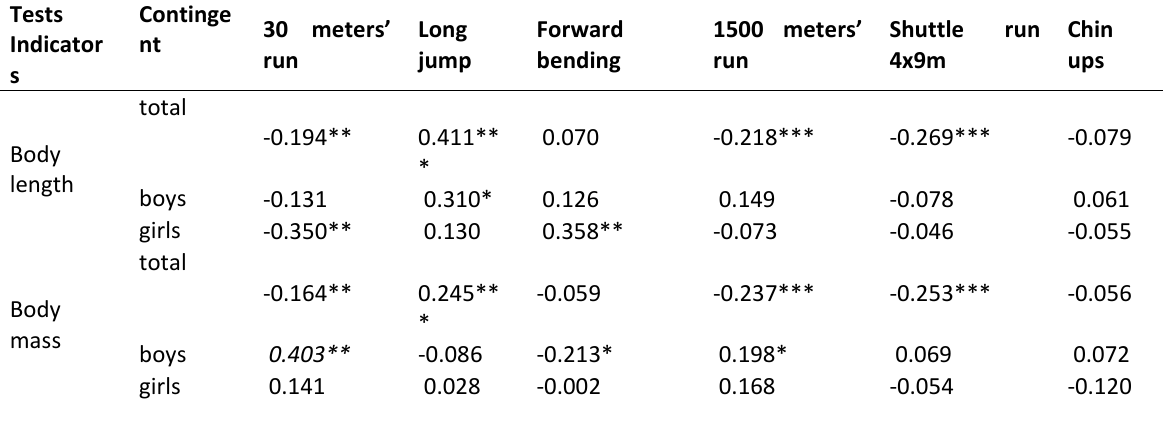
Table 1. Closeness of physical condition indicators’ correlation to results of test exercises, fulfilled by senior pupils ( n